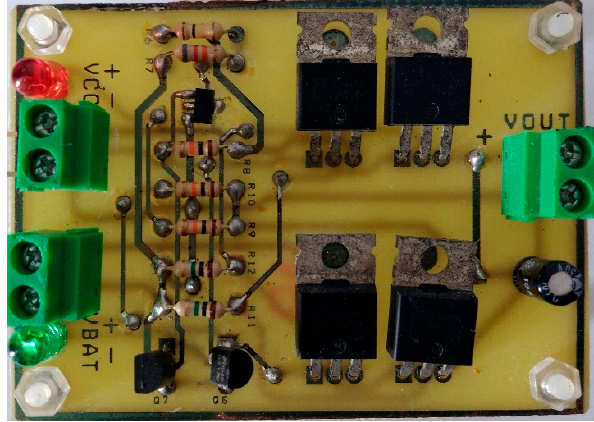
Figure 10. Circuit implementation of the proposed dual power source switch.